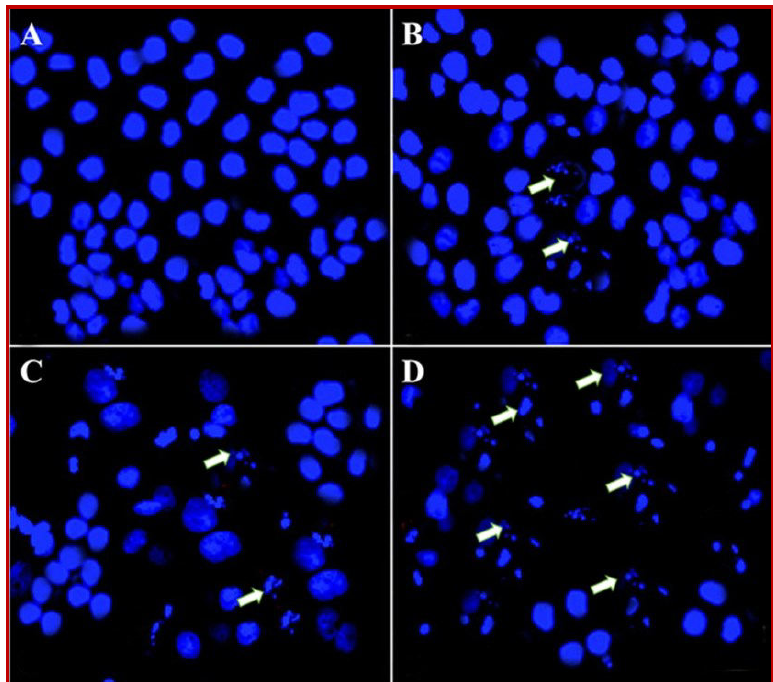
Figure 6: Fluorescence microscopy images of ME-180 cervical cancer cells after treatment with 0 (A), 9 (B), 36 (C) and 72 (D) µM dose of triazolyl derivative of beta-bisabolol for 48 hours. The cells were stained with Hoechst 33258. Note the chromatin conden- sation, fragmented nuclei and nuclear shrinkage (white arrows) which increased with the increasing dose of TTB